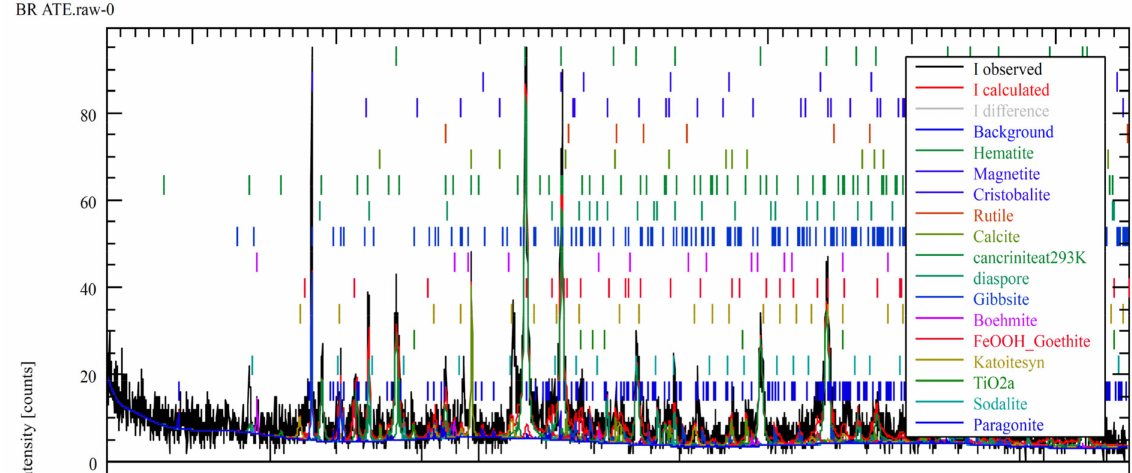
Figure 1. ( a ) Phases of BR from ALUM. ( b ) Phases of BR from ETI.